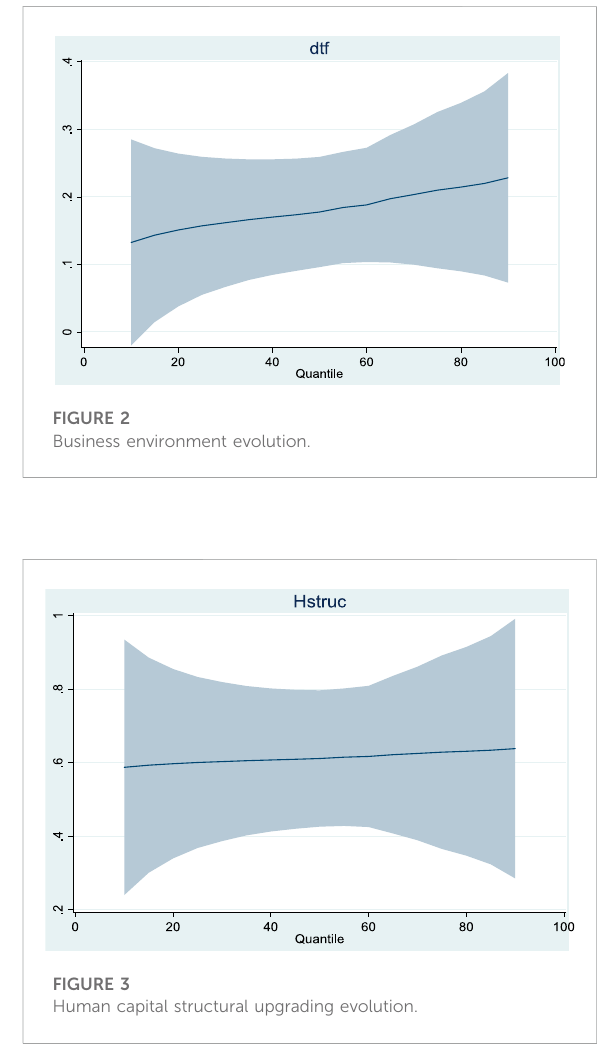
FIGURE 3 Human capital structural upgrading